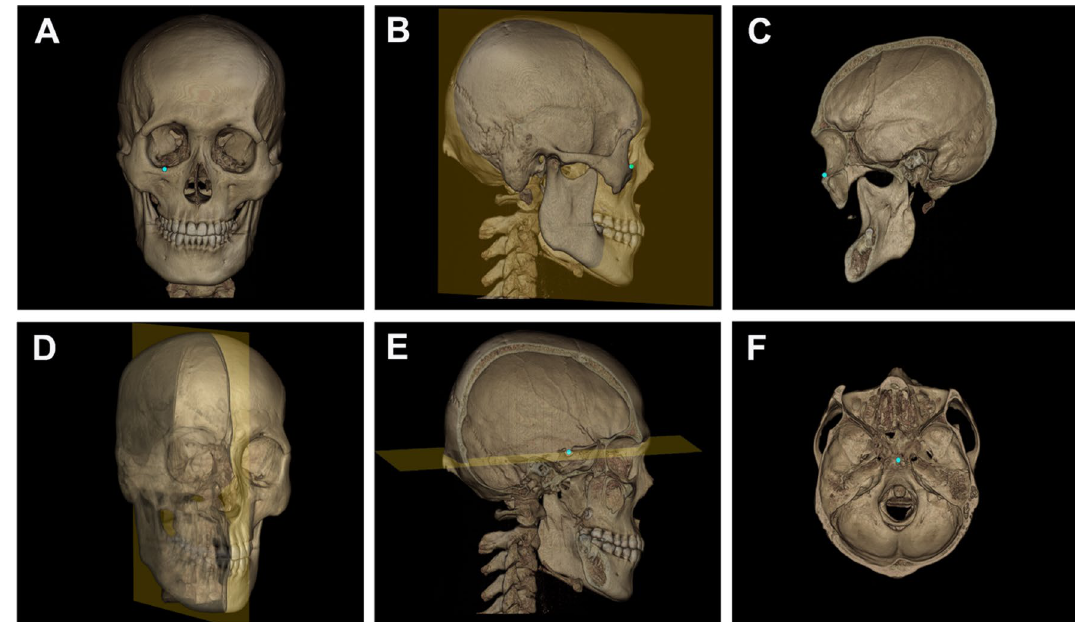
Figure 1. The sequential selection of observational views in multiple stages for 3D landmark pointing, considering the anatomical characteristics of landmarks. Blue points indicate reference points determined by clinical experts. ( A – C ) a multiple-staged directional sequence for right orbitale. ( A ) Anterior view, ( B ) right lateral view, and ( C ) sagittal cut left lateral view. ( D – F ) a multiple directional sequence for sella point. ( D ) Semi lateral 3D view with transparent half skull. ( E ) Sagittal cut right view, and ( F ) axial cut top